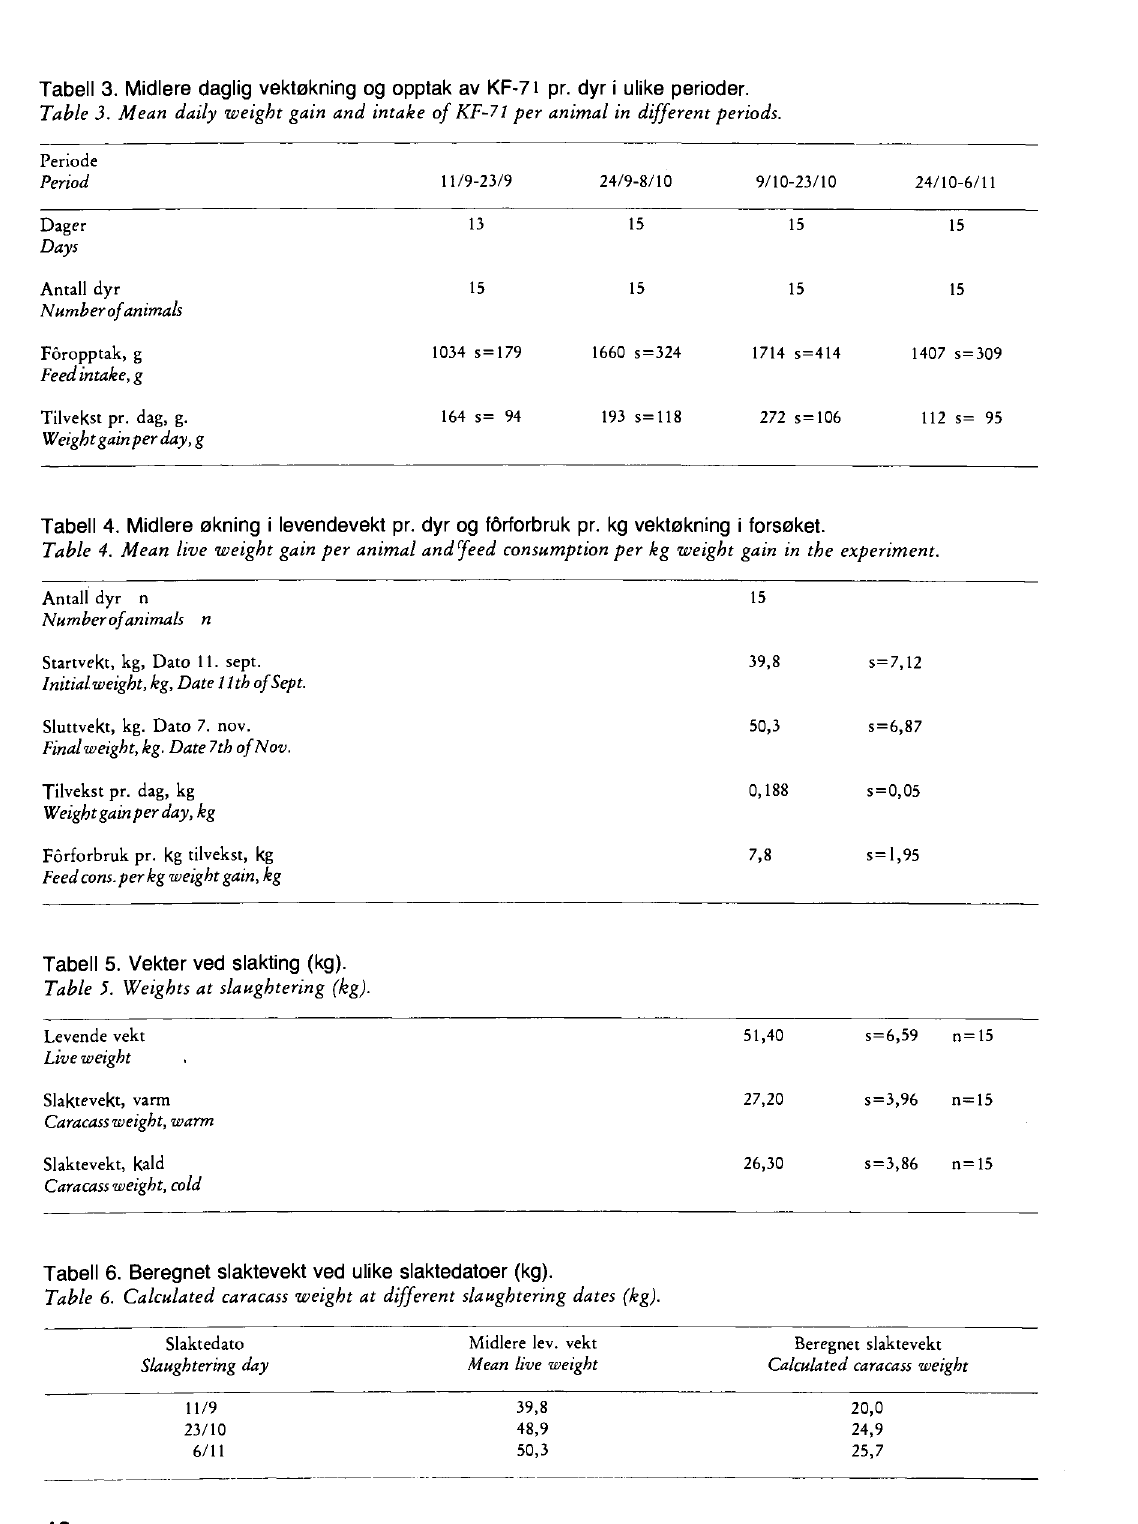
Tabell 3. Midlere daglig vektøkning og opptak av KF-71 pr. dyr i ulike perioder. Table 3. Mean daily weight gain and intake of KF-71 per animal in different periods. Periode Period